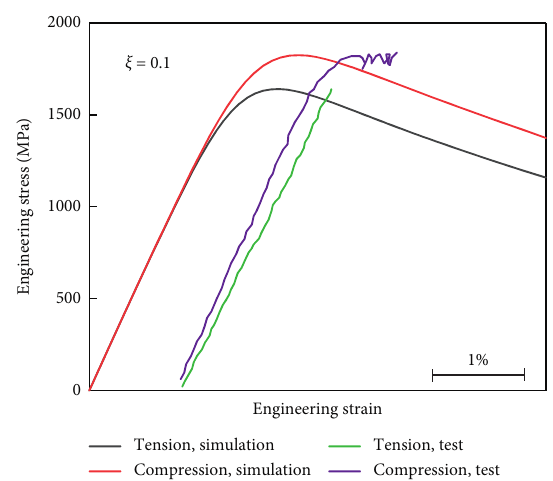
Figure 2: Simulated engineering stress-strain curves under tensile and compressive loadings, both simulation and test re- sults